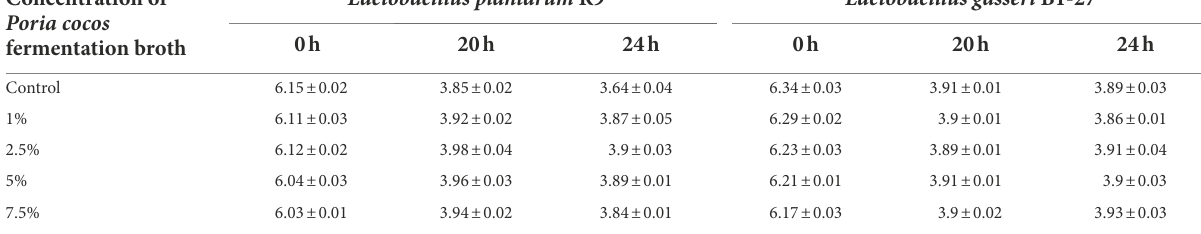
TABLE 2 pH of the Lactobacillus plantarum R9 and Lactobacillus gasseri B1-27 fermentation broths with different concentrations of Poria cocos fermentation broth. Concentration of Poria